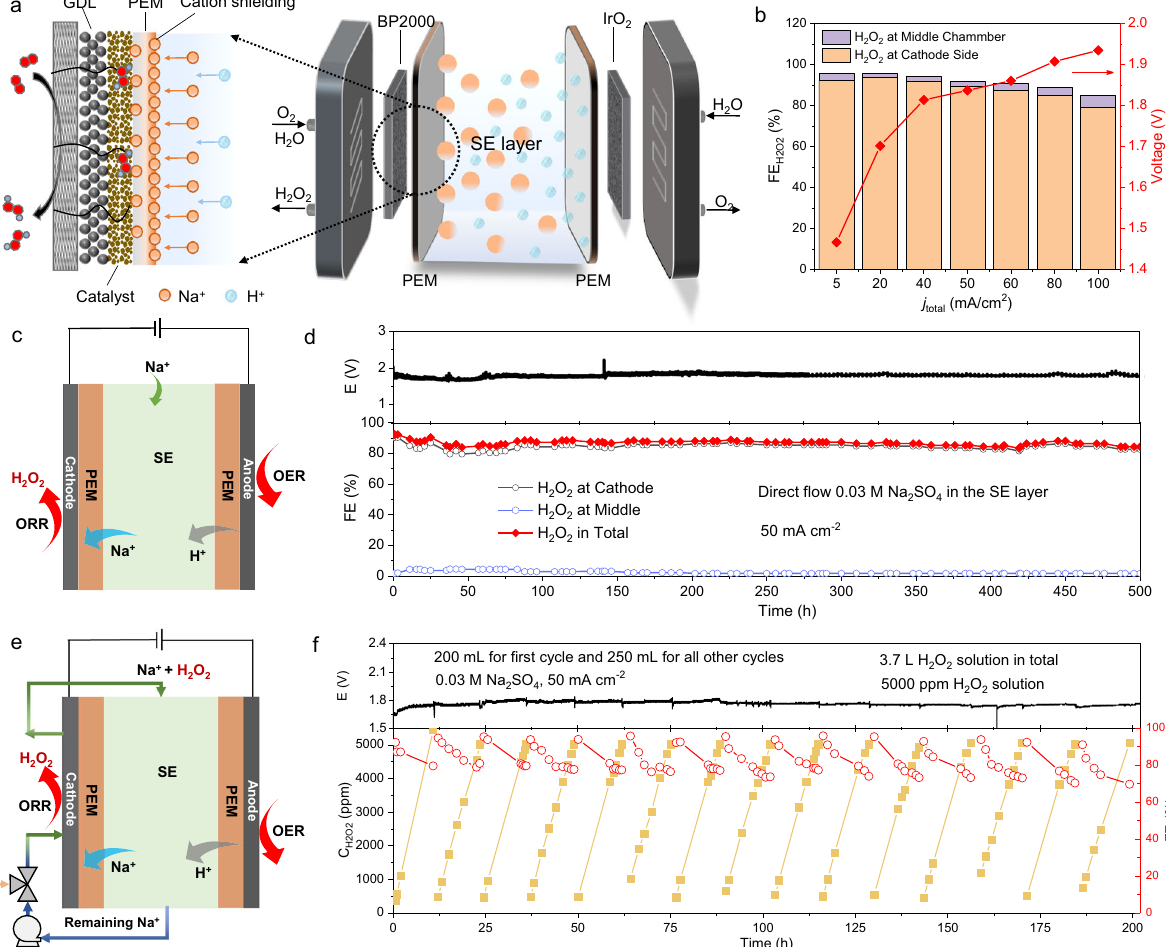
Fig. 6 Continuous production of H 2 O 2 solution using carbon catalyst in a SE cell with a double-PEM con fi guration. a Schematic illustration of reducing O 2 to H 2 O 2 in our SE cell with double-PEM con fi guration. The O 2 + H 2 O/PEM//SE//PEM/H 2 O cell in which O 2 is reduced at the cathode side to form H 2 O 2 and fl owed out by H fl ow. The cations in the middle chamber cross over the PEM under an applied reduction potential and move to the cathode, protecting the 2 O catalyst surface for the production of H 2 O 2 . b The I – V curve and corresponding FEs for producing H 2 O 2 using the SE cell with double-PEM con fi guration through fl owing 0.03M Na 2 SO 4 in the middle chamber. The concentration of Na 2 SO 4 can be varied. c , d The schematic illustration and chronopotentiometry stability test of the SE cell with double-PEM con fi guration by directly fl owing 0.03M Na 2 SO 4 solution in the middle chamber at 50mA·cm − 2 current density. The fl ow rate of Na 2 SO 4 solution is 2.7mLmin − 1 . The oxygen gas ( fl ow rate 180 sccm) and DI water ( fl ow rate 10.8mLmin − 1 ) are mixed and fl owed into the cathode to producing H 2 O 2 solution. DI water with fl ow rate of 2.7mLmin − 1 was circulated at the anode side. e , f The schematic illustration and chronopotentiometry stability test of the SE cell for practically producing 5000ppm H 2 O 2 solution. The volume of Na 2 SO 4 stock solution in the fi rst cycle is 200mL, and the other 14 cycles hold 250mL. The SE cell can produce around 3.7L 5000ppm H 2 O 2 solution in 15 cycles for more than 200h. The liquid fl ow rate is 4.5mLmin − 1 and the O 2 gas fl ow rate is 140sccm. The total geometric area of the fl ow fi eld in the cathode of our SE cell is 4cm 2